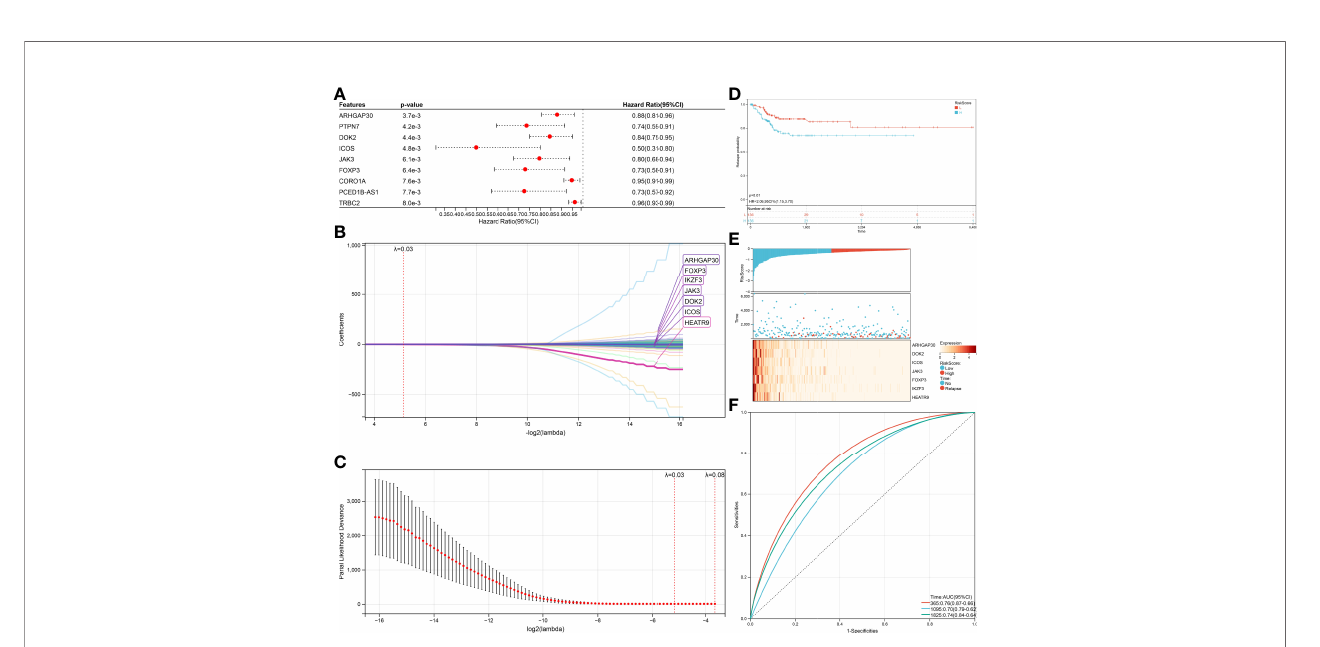
FIGURE 6 | Veri fi cation of the prognostic risk models. (A) KM curves of different RiskScore in the survival-related model. (B) RiskScore and survival time with survival status pro fi le and expression levels of the nine gene signatures. (C) ROC curve validation for survival-related model. (D) KM curves of different RiskScore in the relapse-related model. (E) RiskScore and relapse time with relapse status pro fi le and expression levels of the seven gene signatures. (F) ROC curve validation for relapse-related